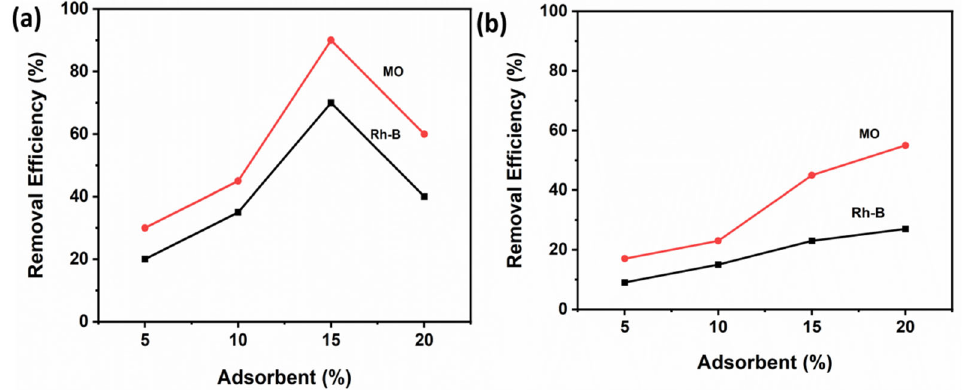
Figure 8. Adsorption efficiency of methyl orange and Rh ‐ B on cinnamic acid modified bentonite ( a ) and on raw bentonite ( b ).